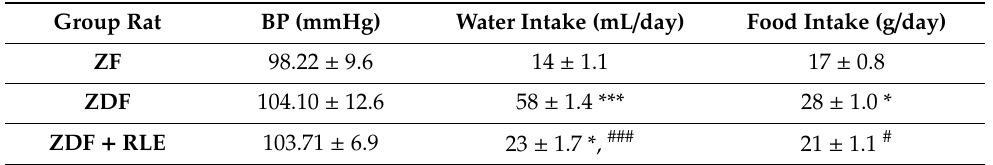
Data are expressed as mean ± standard deviation (DS), n = 9, * p < 0.05 and *** p < 0.001 versus ZF, # p < 0.05 and ### p < 0.001 versus